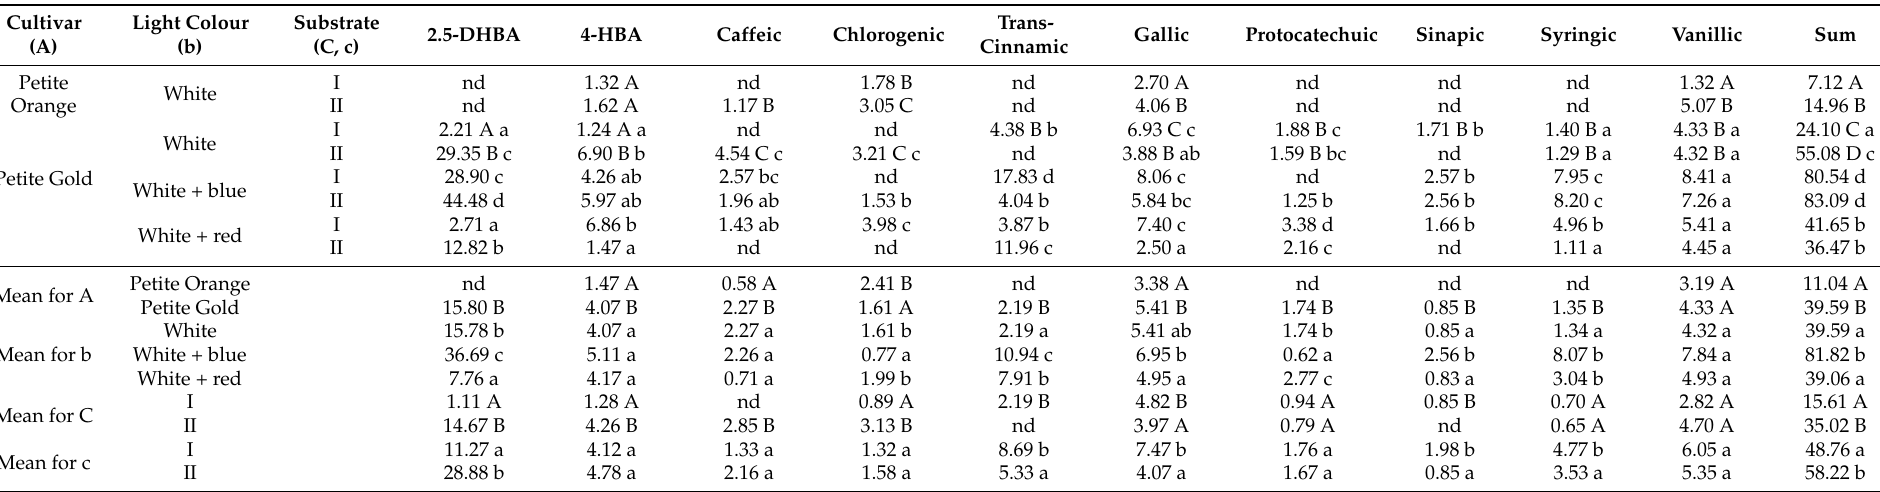
Table 4. Profiling of phenolic acids of the Tagetes patula flowers depending on cultivar and substrate under white light (big letters) and profiling of flavonoids of the Tagetes patula ‘Petite Gold’ flowers depending on light colour and substrate (small letters) [ µ g · g − 1